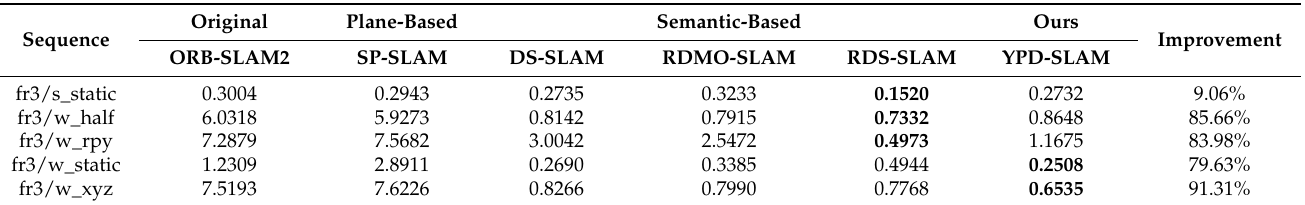
Table 3. Experimental RMSE results of rotational relative pose error (RPE). Our method is YPD-SLAM, and Improvement stands for comparison with the original algorithm ORB-SLAM2.